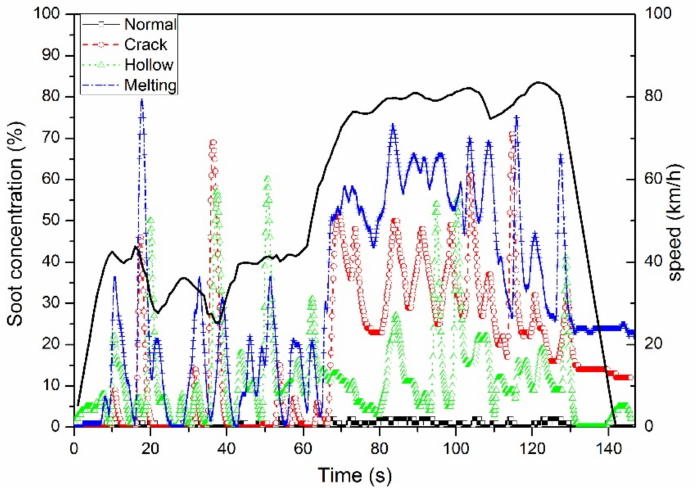
Figure 11. Variation in soot emission during KD-147 driving mode (black line) for 4 types of DPF sample.